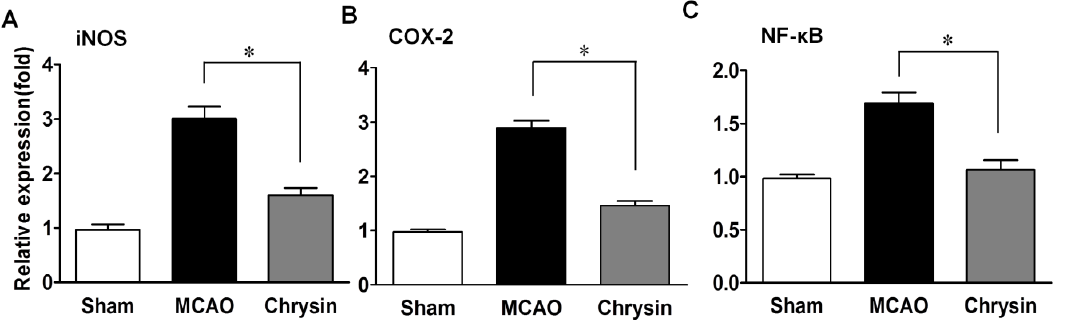
Figure 4. Chrysin pretreatment suppresses the mRNA expression of iNOS ( A ), COX-2 ( B ) and NF-κB ( C ) in the MCAO model. Representative mRNA expression of iNOS , COX-2 and NF-κB detected by RT-PCR. Compared to the MCAO group, chrysin pretreatment also inhibited the mRNA expression of iNOS , COX-2 and NF-κB . Data are expressed as means ± SEM, * p < 0.05, vs. MCAO group, n =